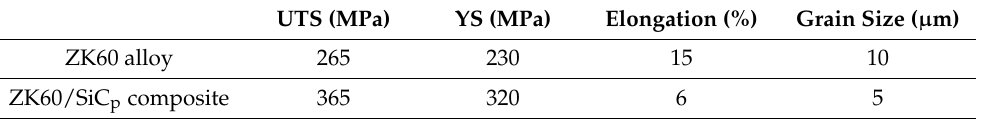
Table 1. Mechanical properties and grain size of the KoBo extruded and aged samples.